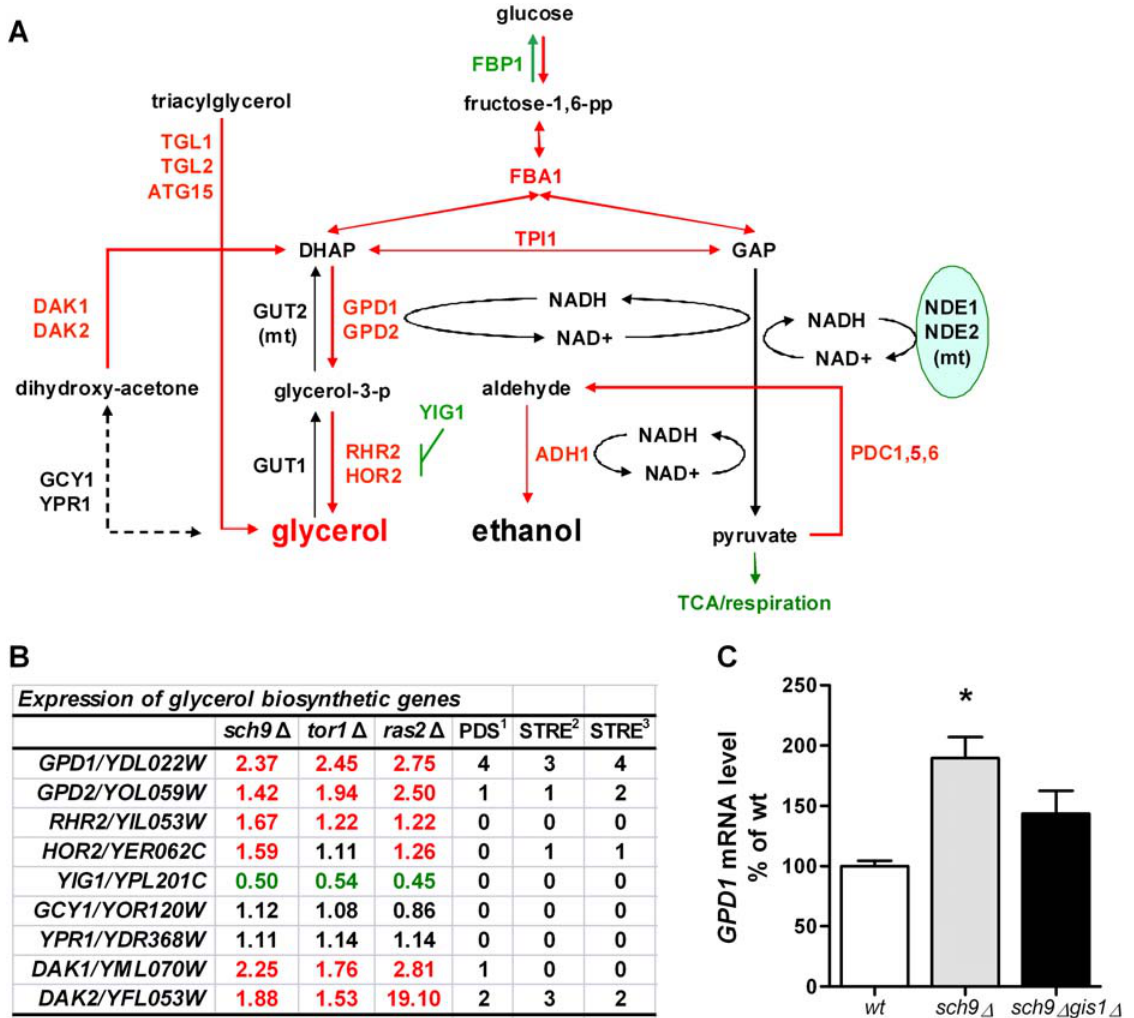
Figure 3. Expression of the glycerol biosynthesis genes. (A) Schematic representation of glycerol metabolism. For illustration purpose, genes up- or down-regulated more than 20%, compared to wild type (DBY746) in all three long-lived mutants, are labeled in red or green, respectively. (B) Fold change in expression levels of glycerol biosynthetic genes in sch9 D , tor1 D , and ras2 D mutants compared to wild type at day 2.5 (for complete microarray data, see Table S2 and Table S6). Data were expressed in fold change, WT=1. Gene expression levels that are 20% higher or lower than wild type cells are marked in red or green. 1 Predicted PDS motif: AWAGGGAT; 2 predicted STRE motif: ARGGGG; 3 predicted STRE motif: AGGGG. (C) Real time quantitative PCR analysis of GPD1 mRNA level sch9 D and sch9 D gis1 D cells at day 2.5. Data represent mean and SEM, n=4. * p , 0.05, t- test, two-tailed, sch9 D vs. WT.